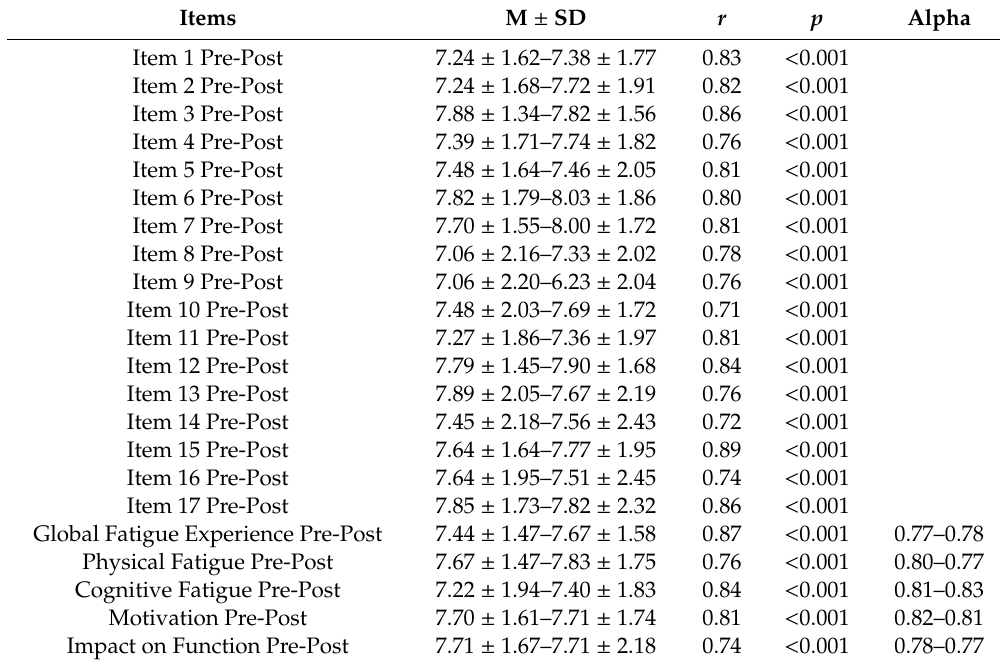
Table 1. Test-retest reliability analysis (Portuguese sub-sample =